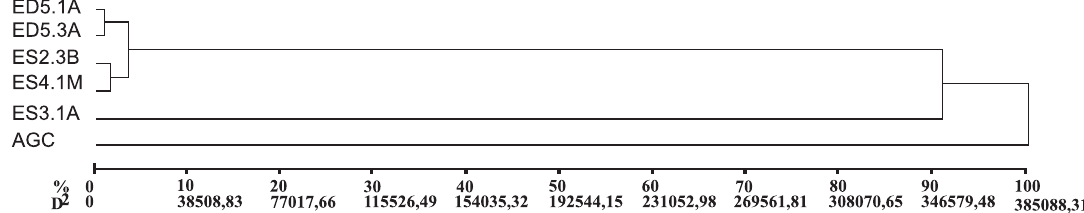
Figure 2. Clustering of Rhizoctonia -like fungi based on the proportions of fatty acids using the distance of Mahalanobis (D2) and UPGMA method. Codes in the clusters correspond to the isolates presented in